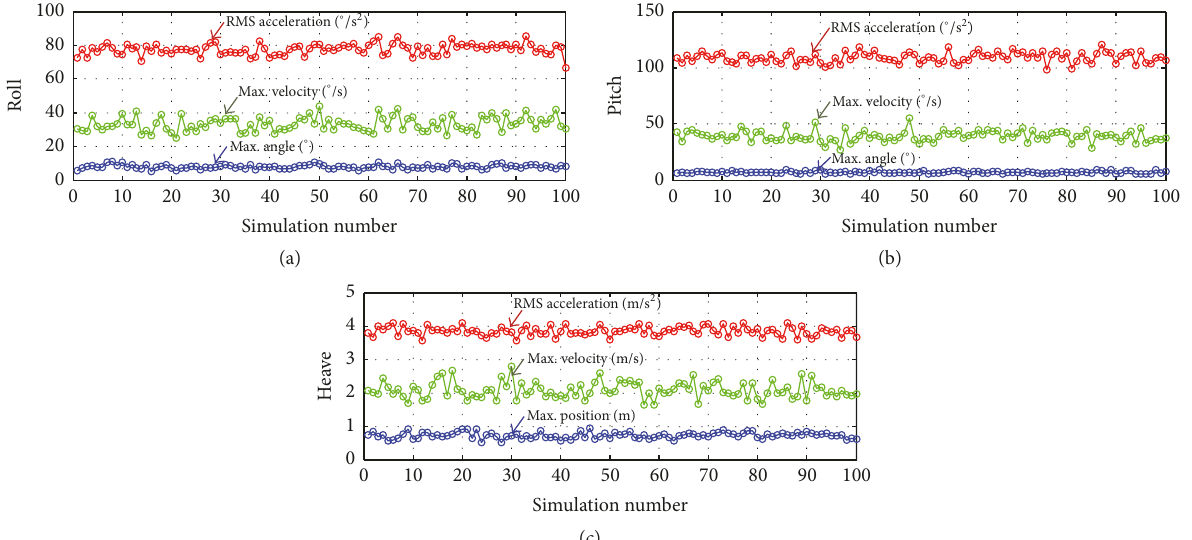
Figure 11: Graphs for maximum position, velocity, and RMS acceleration of USV roll/pitch/heave motion through 100 operation simulations. (a) Roll motion; (b) pitch motion; (c) heave